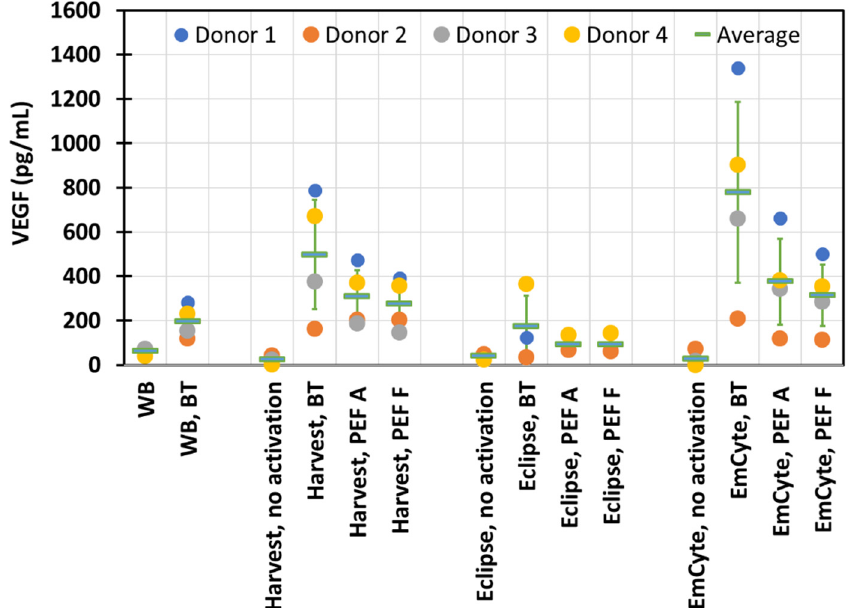
Figure 3. VEGF release for: whole blood (WB)—no activation and bovine thrombin (BT) activation; Harvest PRP (no activation, bovine thrombin—BT-activation, and activation using electric stimulation with pulses A and F); Eclipse PRP (no activation, bovine thrombin—BT-activation, and activation using electric stimulation with pulses A and F); EmCyte PRP (no activation, bovine thrombin— BT-activation, and activation using electric stimulation with pulses A and F). Note that there is no Donor 3 data for Eclipse.